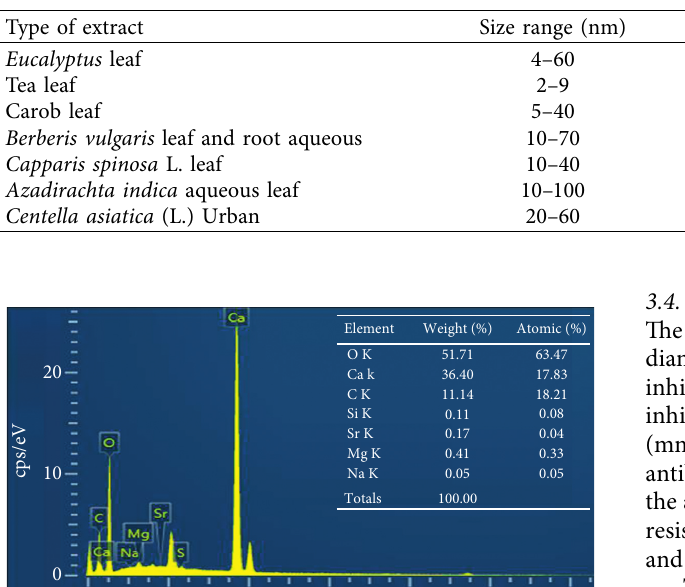
Table 1: The size of the silver nanoparticles synthesized from extracts of various plants.